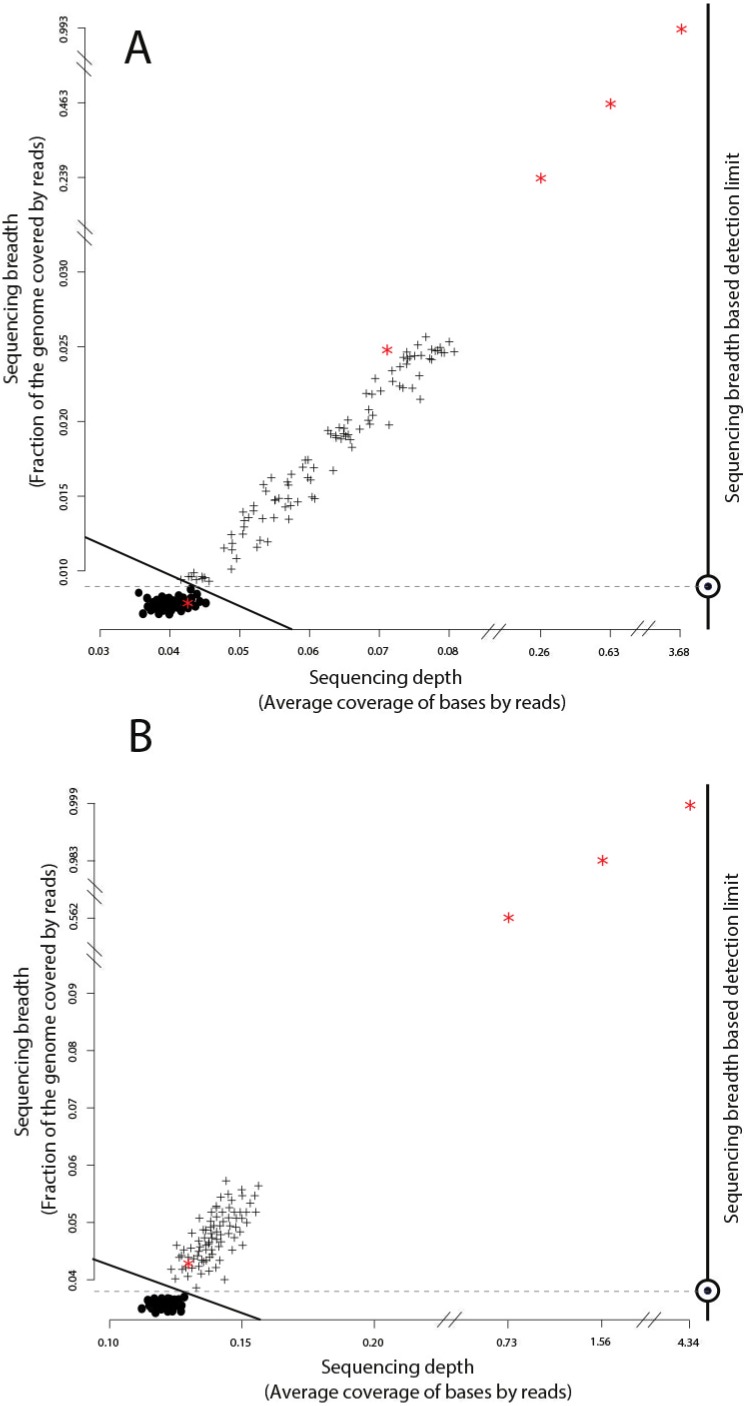
Identification of target genomes in metagenomic datasets with imGLAD.Positive datasets (crosses) are separated from negative datasets (dots) through a logistic function (solid line) based on in-silico training datasets. (A) Datasets with reads of E. coli are separated from negative datasets. (B) Datasets with reads of B. anthracis are separated from negative datasets. Red asterisks denote the position of the experimental metagenomes (remaining dots represent in-silico generated datasets). Note the differences in scale on the x-axes between positive and negative datasets.